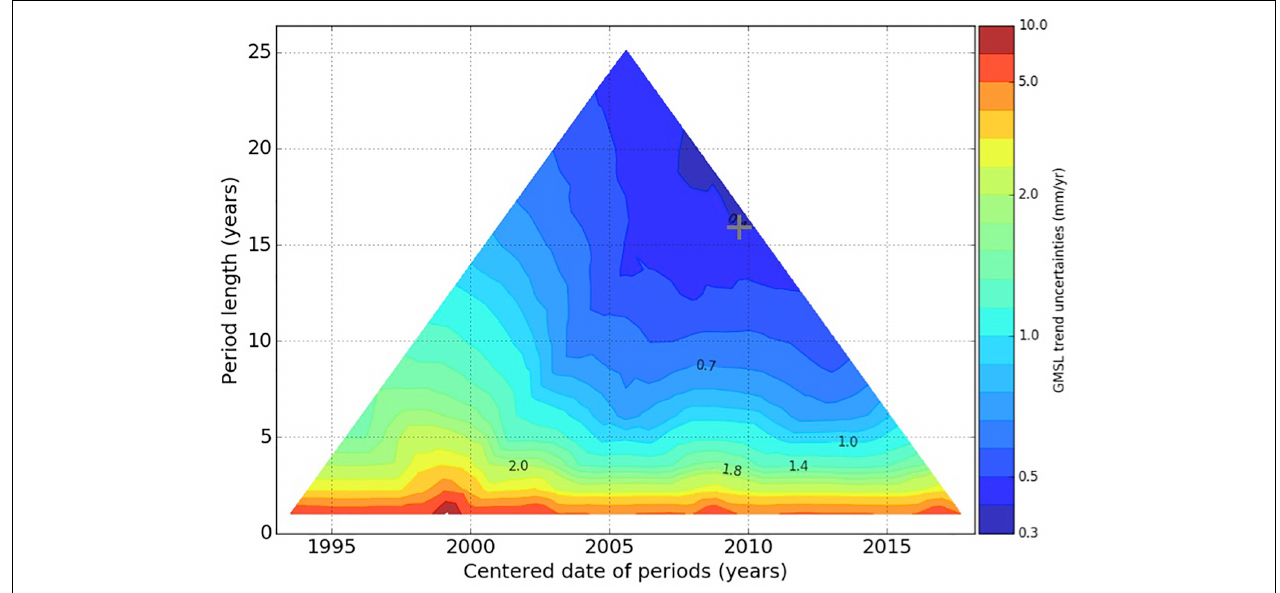
FIGURE 7 | GMSL trend uncertainties (mmyr − 1 ) estimated for any altimeter period between 1993 and 2017. The Y -axis represents the length of the period over which the trend is computed (in years). The X -axis represents the central date of the period over which the trend is computed (in years). The colorbar indicates the uncertainty associated to trend in sea level. The confidence level is 5–95% (1.65-sigma because we assume a Gaussian distribution). The gray cross indicates the value taken for filling Table 2 . Figure updated from Ablain et al.